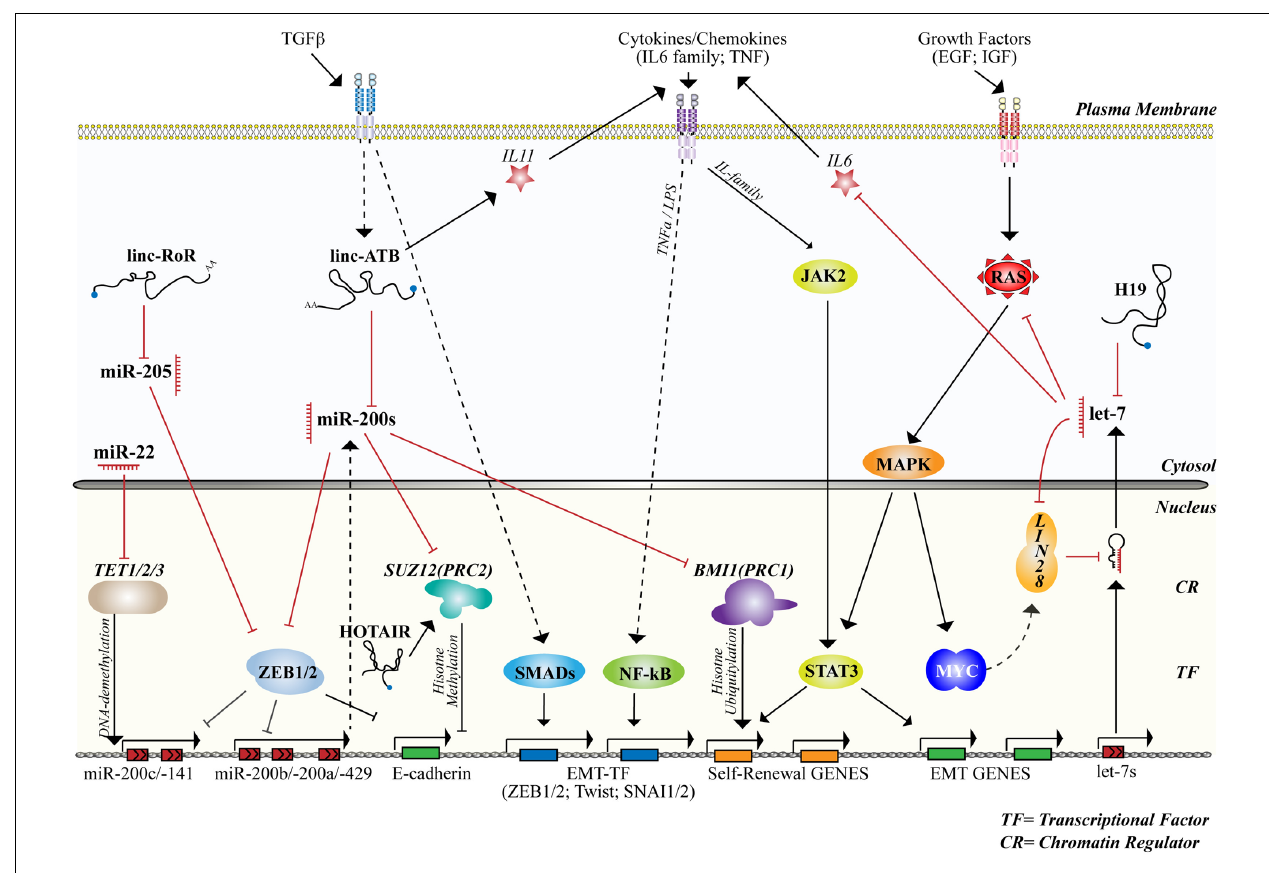
framework (nucleus) to which they belong or that they regulate. Straight and dashed arrows refer to direct or indirect interaction/regulation, respectively. Red lines mark inhibitory interactions.The activity of transcriptional factors (TFs) and chromatin regulators (CRs), cited in the text and involved in the control of stemness and differentiation, are also